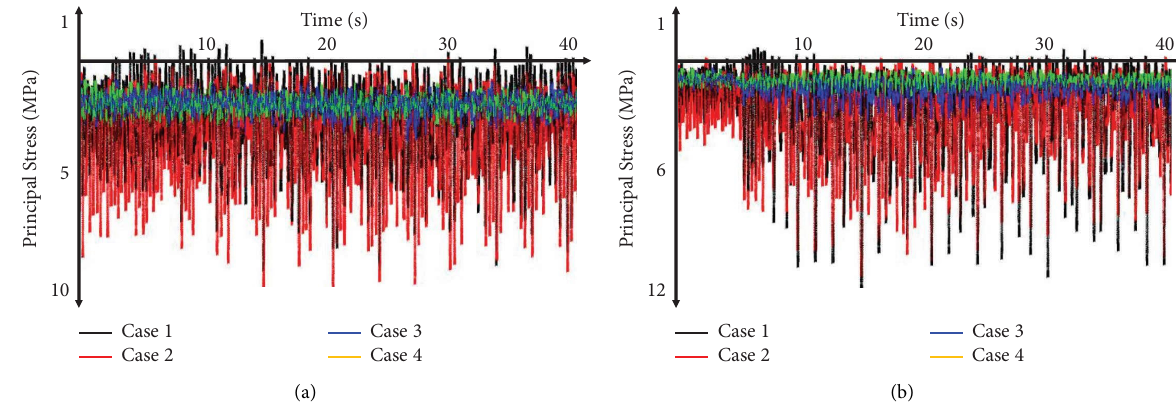
Figure 8: Earthquake PS results of Ermenek arch dam for EQ17-EQ18 earthquakes: (a) EQ17 and (b)